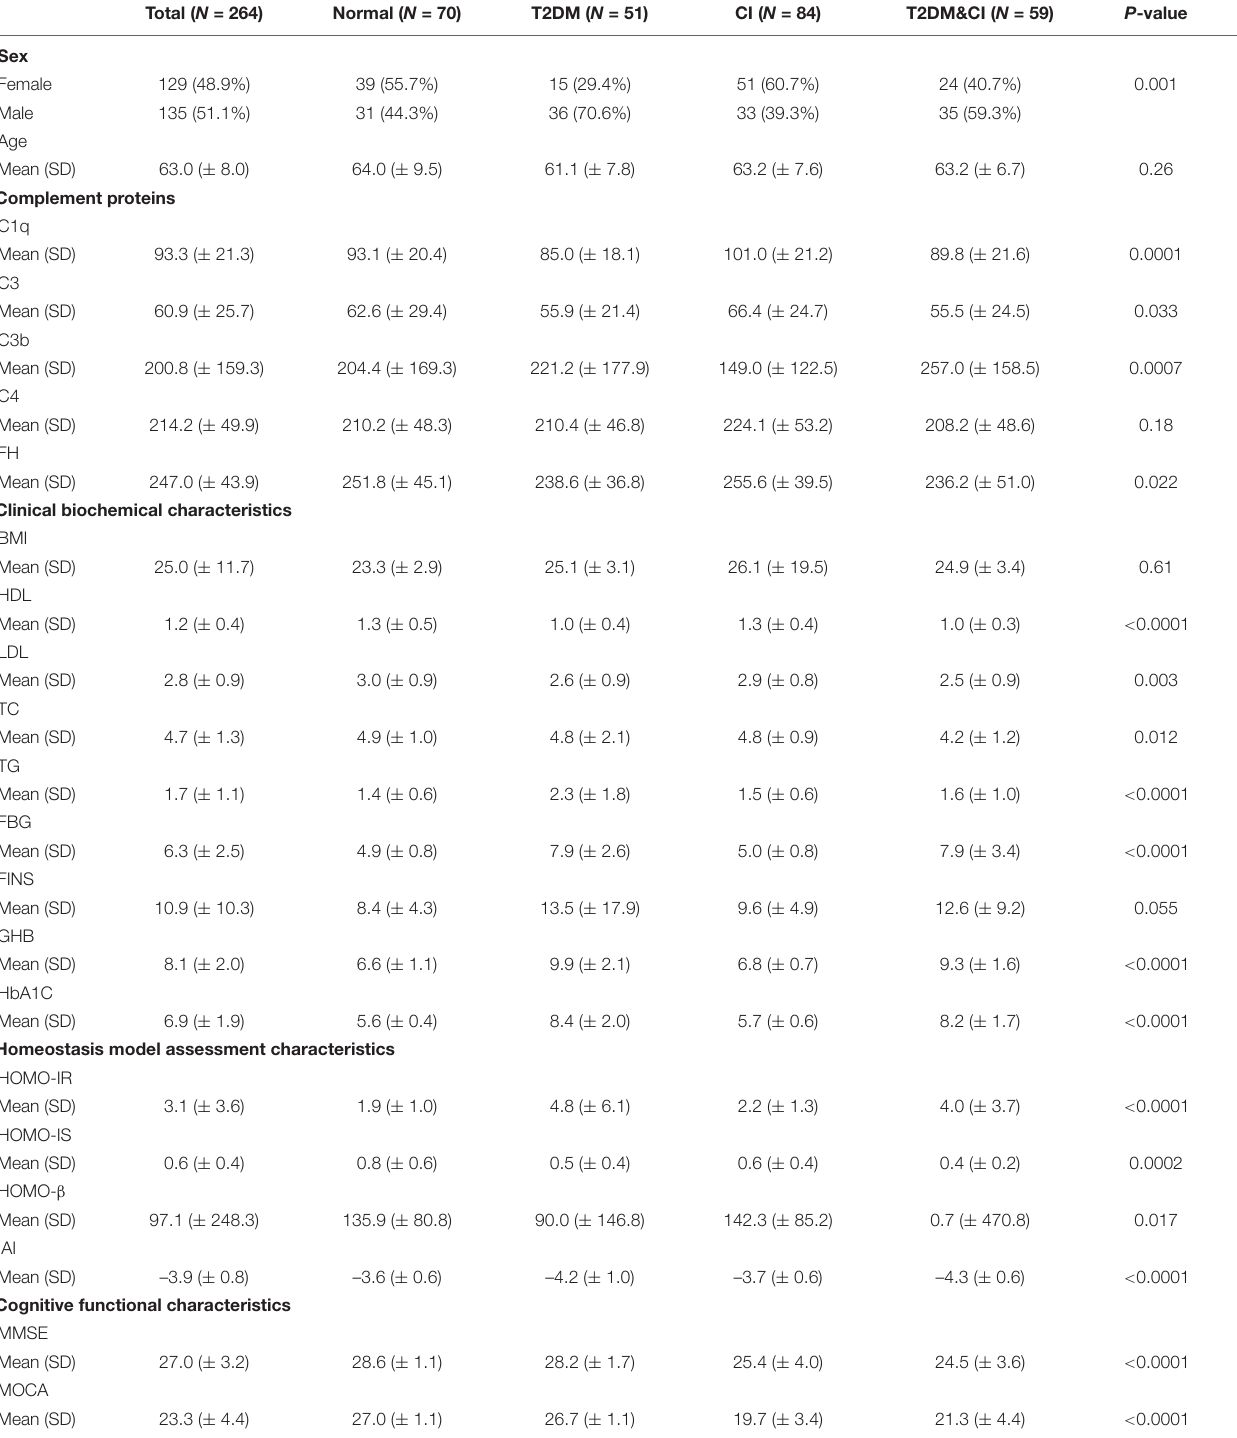
TABLE 1 | Demographic and clinical characteristics of